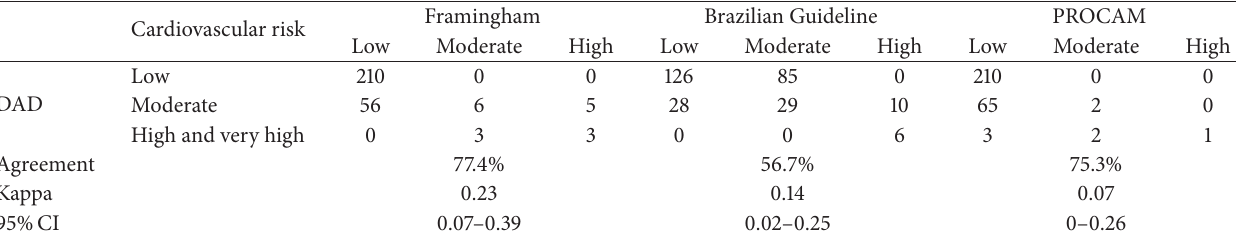
Table 3: Comparison between CVD risk estimation using different equations (283